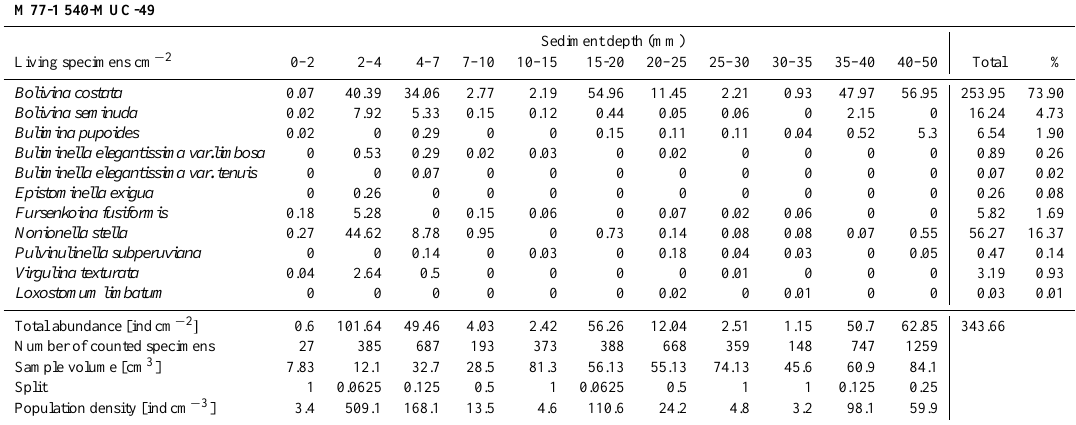
Table A1. Population densities and abundances of living benthic foraminifera as calculated from census data of Mallon (2012). For complete faunal references, see also Mallon